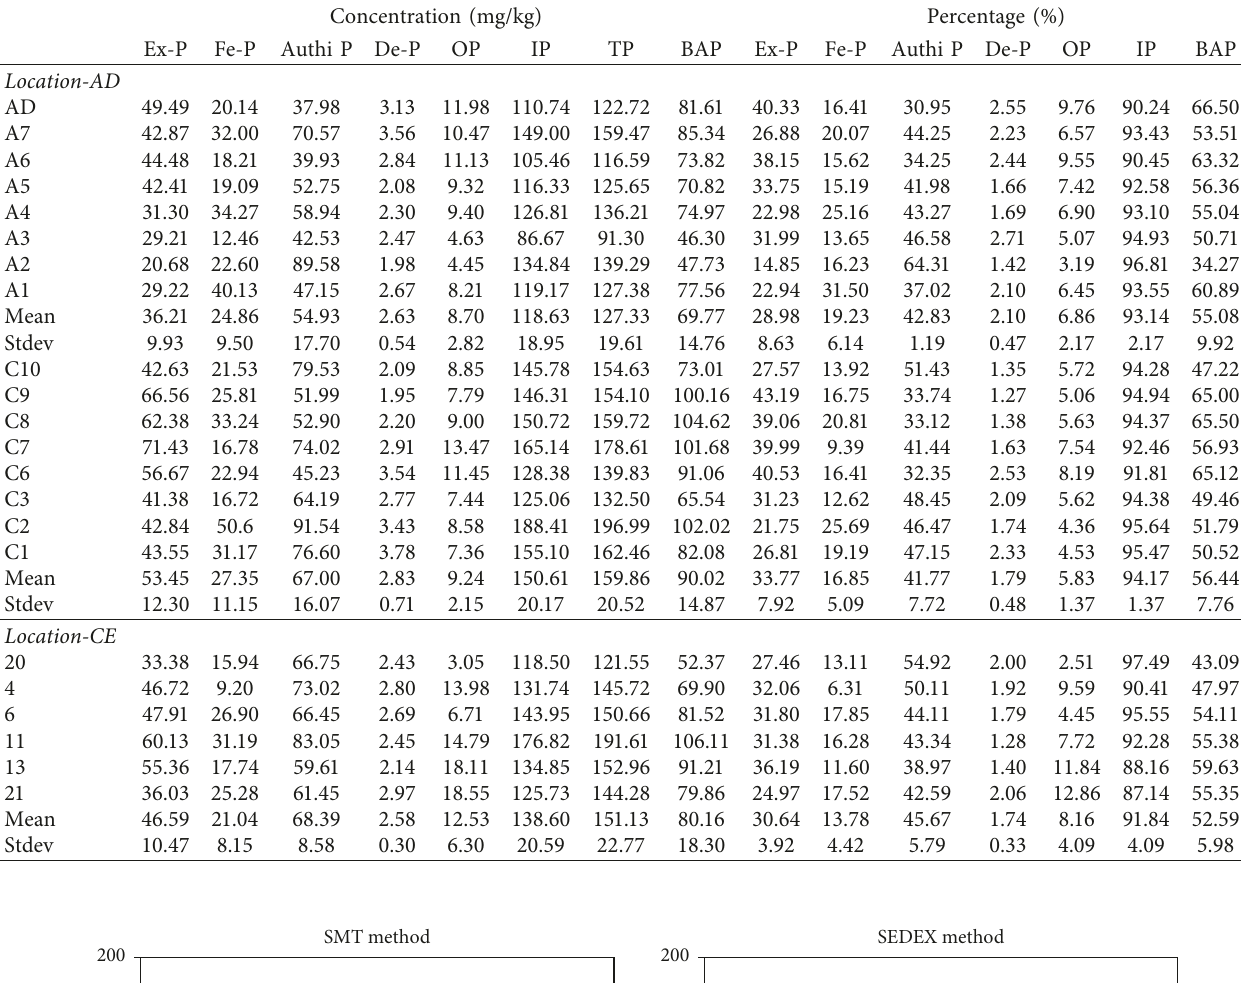
Table 2: Sedimentary P species as elucidated from the SEDEX